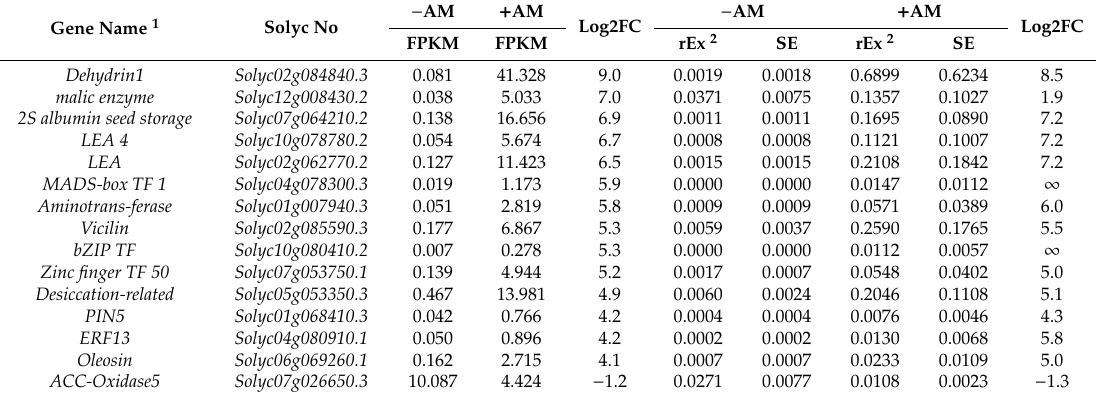
Table 1. Expression level of selected DEGs in green fruits of mycorrhizal ( + AM) and non-mycorrhizal ( − AM)